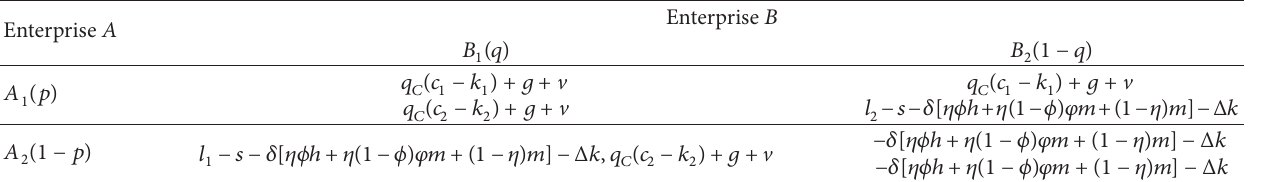
Table 1: The strategic payoff matrix of the